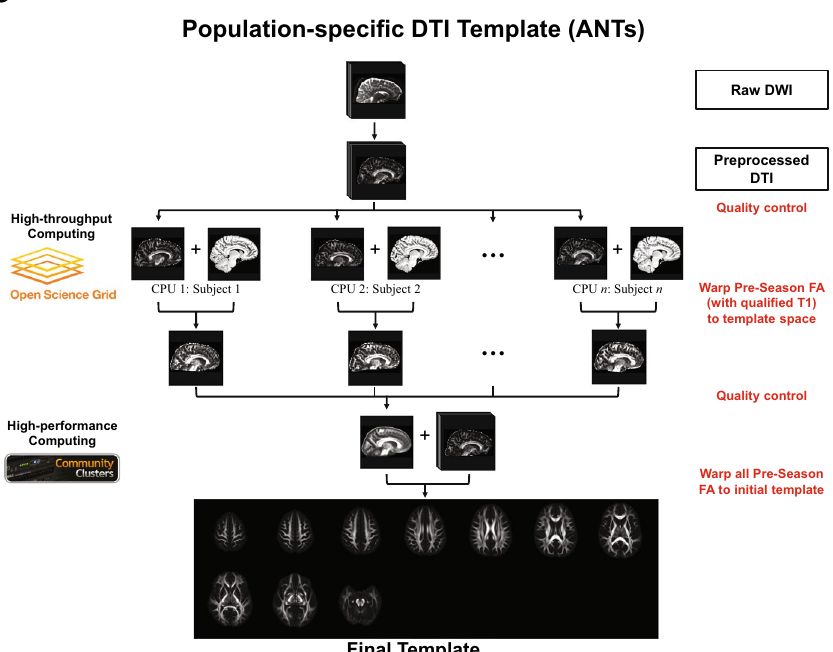
Figure 4. High-throughput high-performance computing workflow, for constructing ( a ) the population- specific T1 template and labels, and ( b ) the population-specific DTI template using Advanced Normalization Tools (ANTs) 57